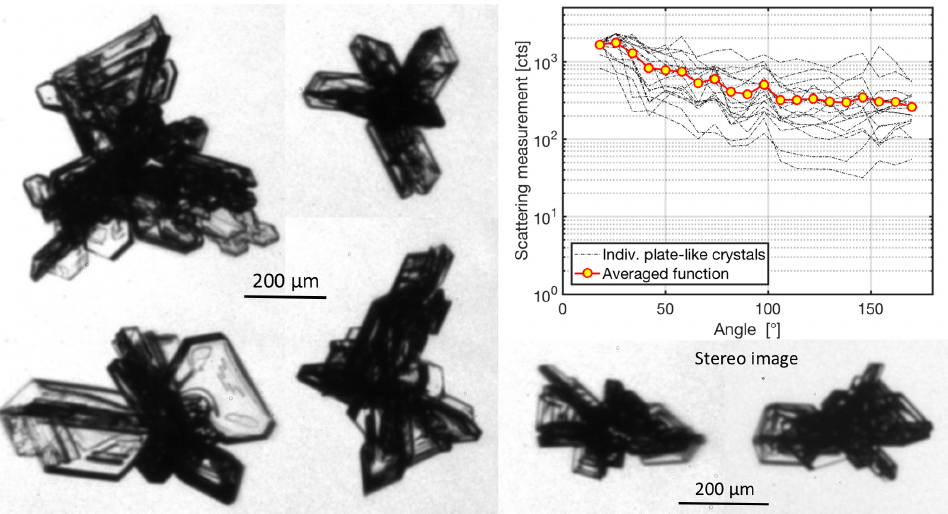
Figure 15. Same as in Fig. 14 but for plate-like and side plane crystals selected from the imagery captured by PHIPS-HALO during the descent through an altostratus cloud od ∼− 28 ◦ C over